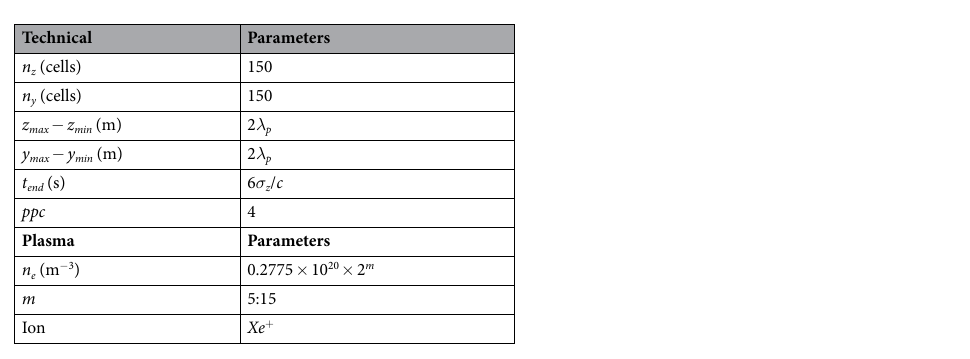
model a micro-bunched beam a tri-gaussian envelope was assumed with a sinusoidal modulation along its length, described by equation 1: